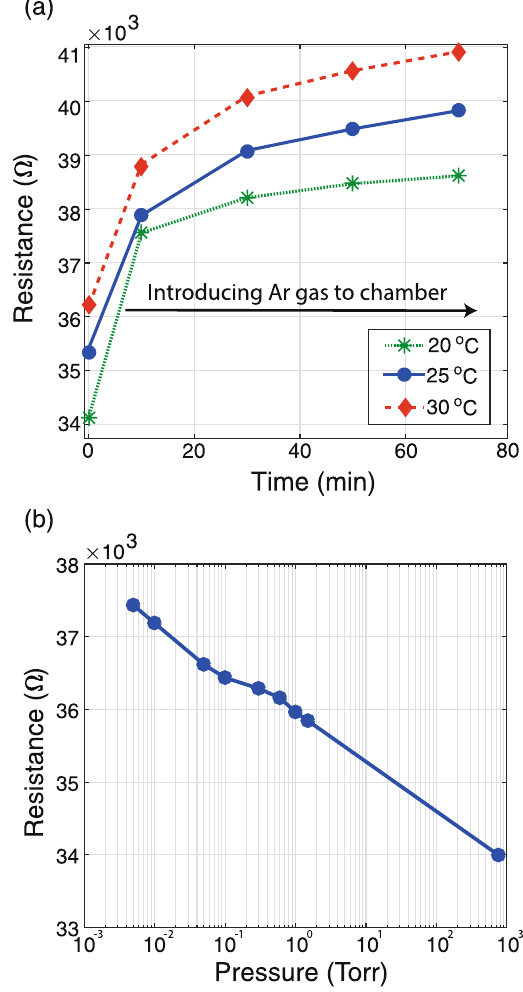
Figure 6. Graphene resistance affected by environments. ( a ) In an inert gas (Ar) environment. The resistance of the graphene increases as the air is replaced by Ar in the chamber and also as the temperature increases. ( b ) In vacuum pressure at room temperature. The lower pressures results in higher